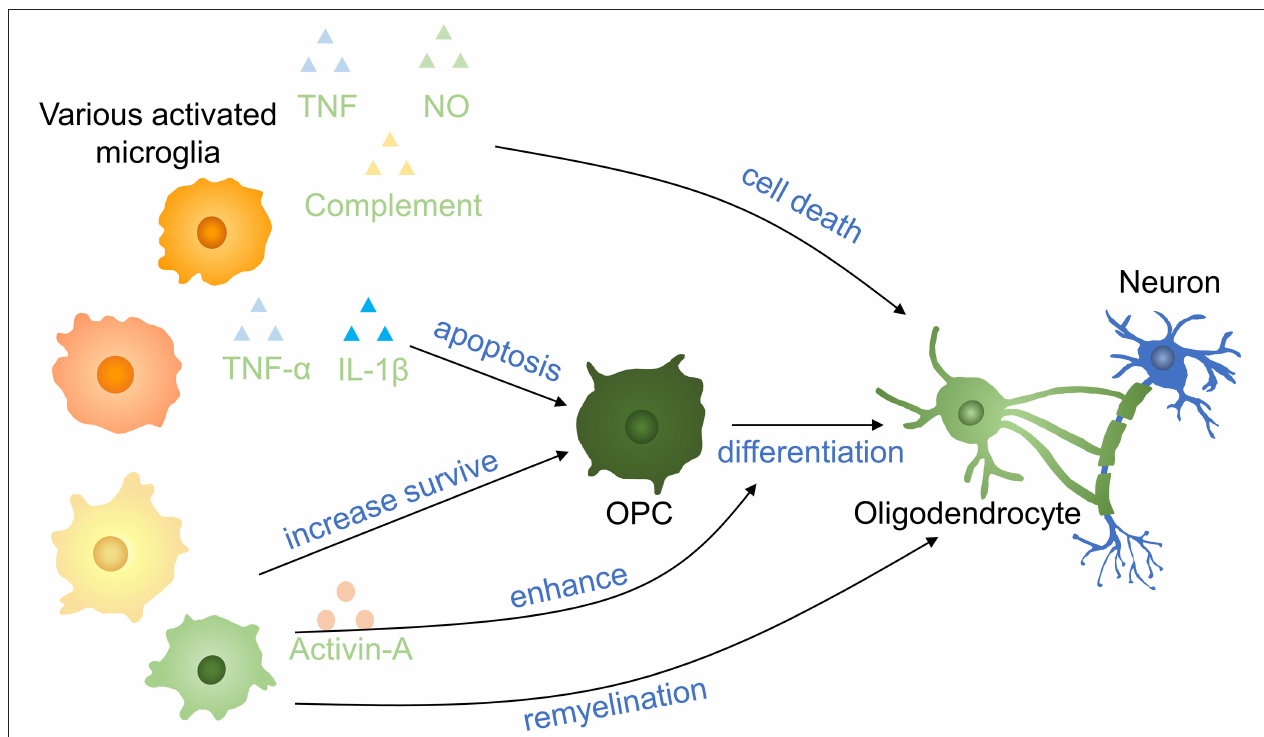
FIGURE 5 | Effects of microglia on oligodendrocytes and OPCs in SCI. Proinflammatory factors induce OPC apoptosis and oligodendrocyte death. Anti-inflammatory cytokinnes increase the survival of OPCs and promote the remyelination of neurons. Activin-A (a TGF- β superfamily member) derived from activated microglia enhances the differentiation of OPCs into oligodendrocytes. OPCs, oligodendrocyte precursor